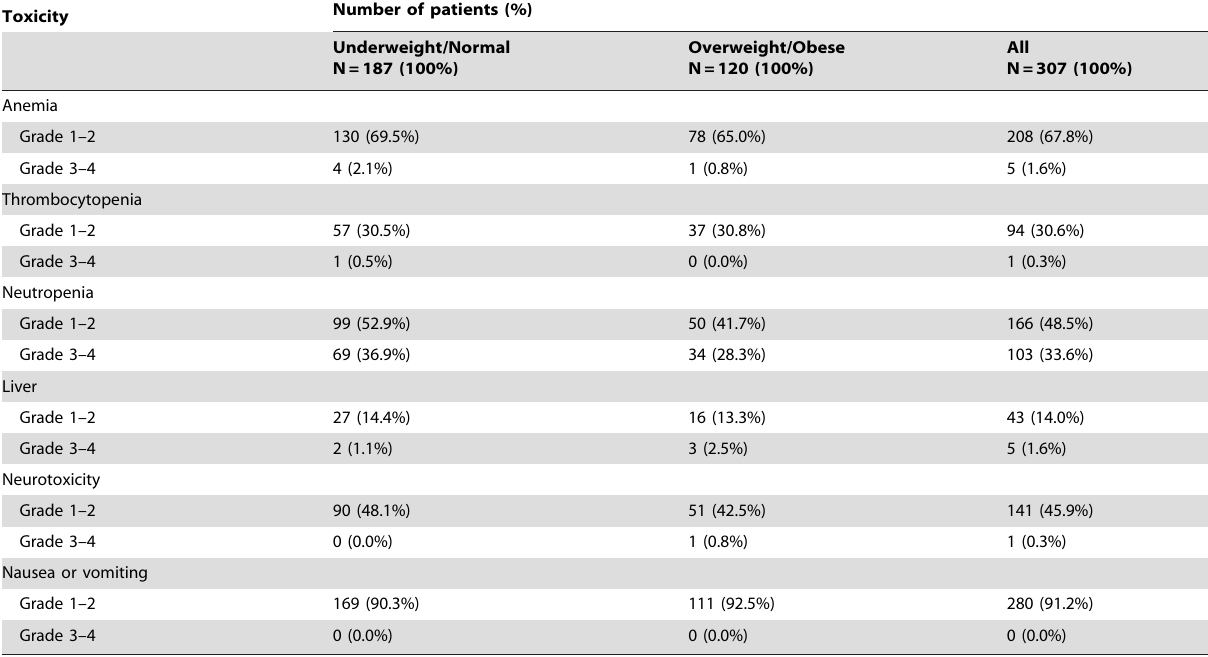
Table 3. Toxicity according to BMI